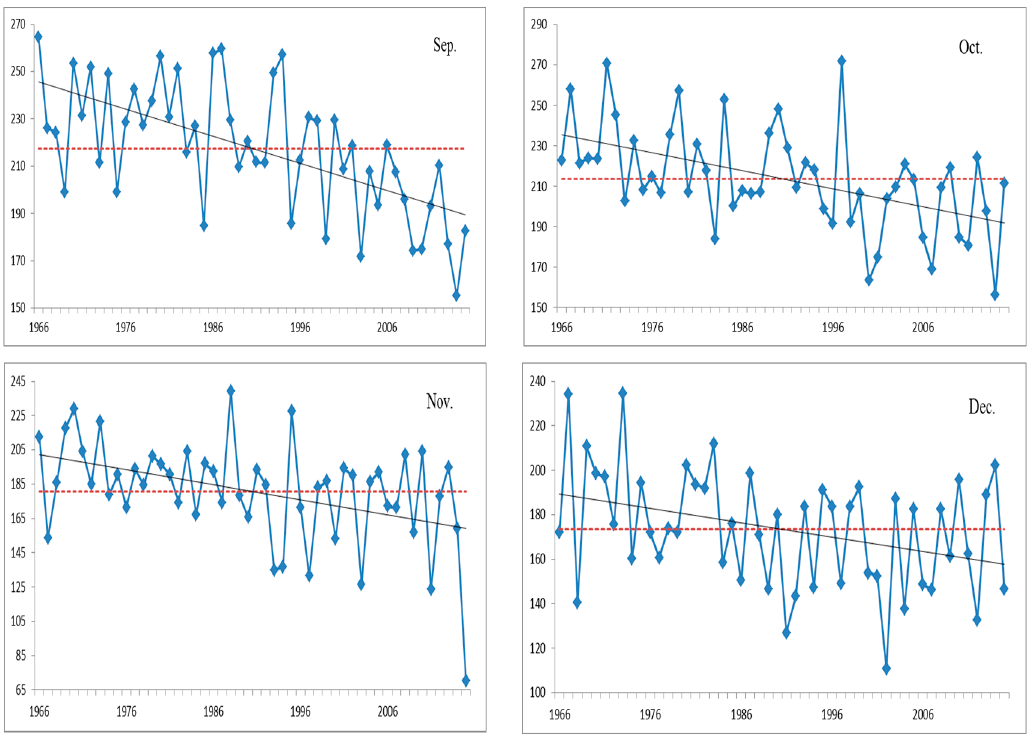
Figure 6. Variability of monthly sunshine duration (blue line) with the average (red line) and linear trend (black line) in the Haihe River basin during 1966–2015. Table 1. Mean monthly sunshine duration in the Haihe River basin during 1966–2015.